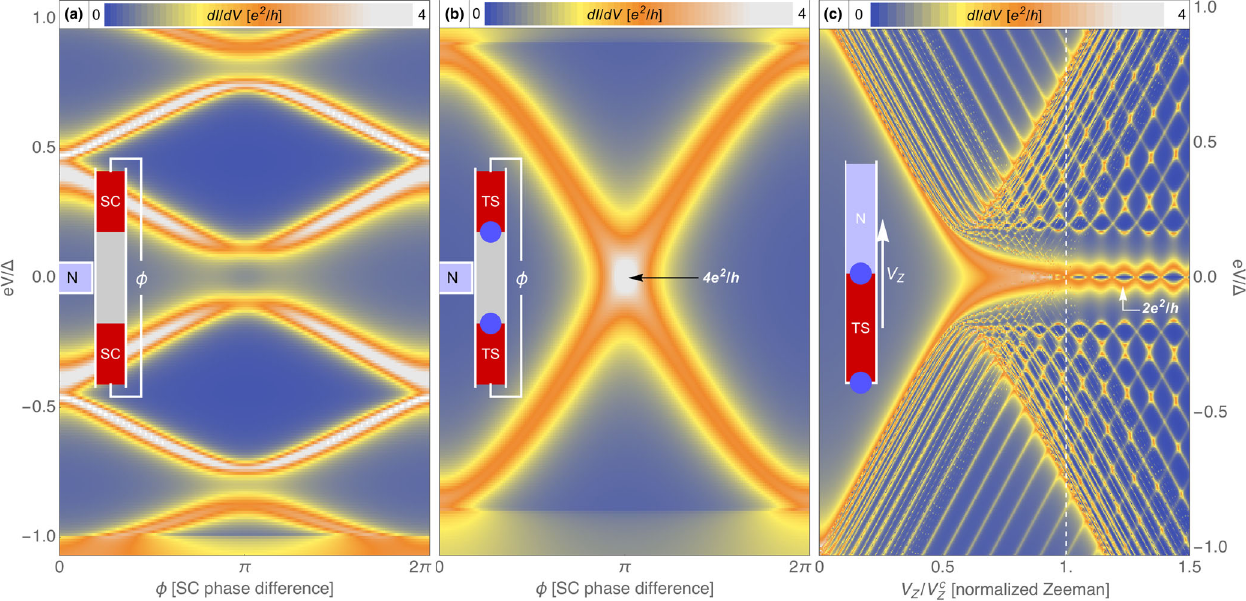
FIG. 5. Transport spectroscopy dI=dV obtained in various arrangements of normal, trivial superconducting (SC), and topological superconducting (TS) nanowires, to be compared to Fig. 3. The wires are modeled after Refs. [16,17]. (a) A trivial SC/normal/SC Josephson junction is probed by a third normal contact at bias V , as a function of the superconducting phase difference ϕ . No protected zero-bias dI=dV anomalies arise. (b) Same as (a) for a TS/normal/TS junction. A universal 4 e 2 =h zero-bias anomaly (white) is obtained at a certain ϕ , here ϕ ¼ π , for which the two Majoranas in the junction (blue circles in the inset) decouple. (c) A normal/SC junction that transitions into normal/TS with two Majoranas as the longitudinal Zeeman field V oscillatory splitting that decays exponentially with TS length, the dI=dV in the latter case shows a universal 2 e 2 =h zero-bias anomaly